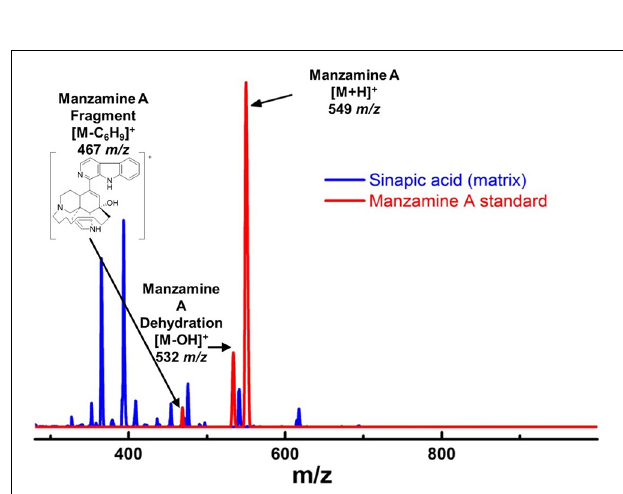
FIGURE 5 | Phylogenetic analysis based on 16S rRNA gene sequence of cultured bacteria isolated from sponge Acanthostrongylophora sp. noted in bold. The red box indicates the location of the manzamine A producing strain.